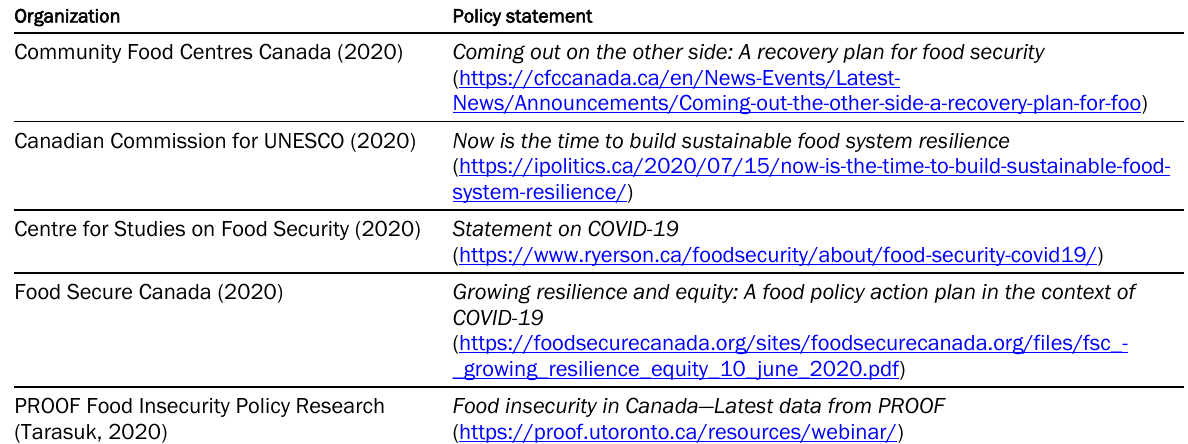
Table 1. Policy Proposals from Civil Society Organizations